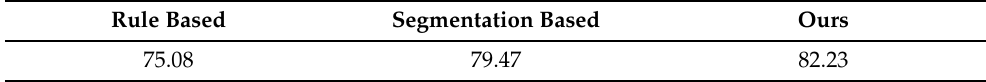
Table 1. Comparison with SOTA road detection